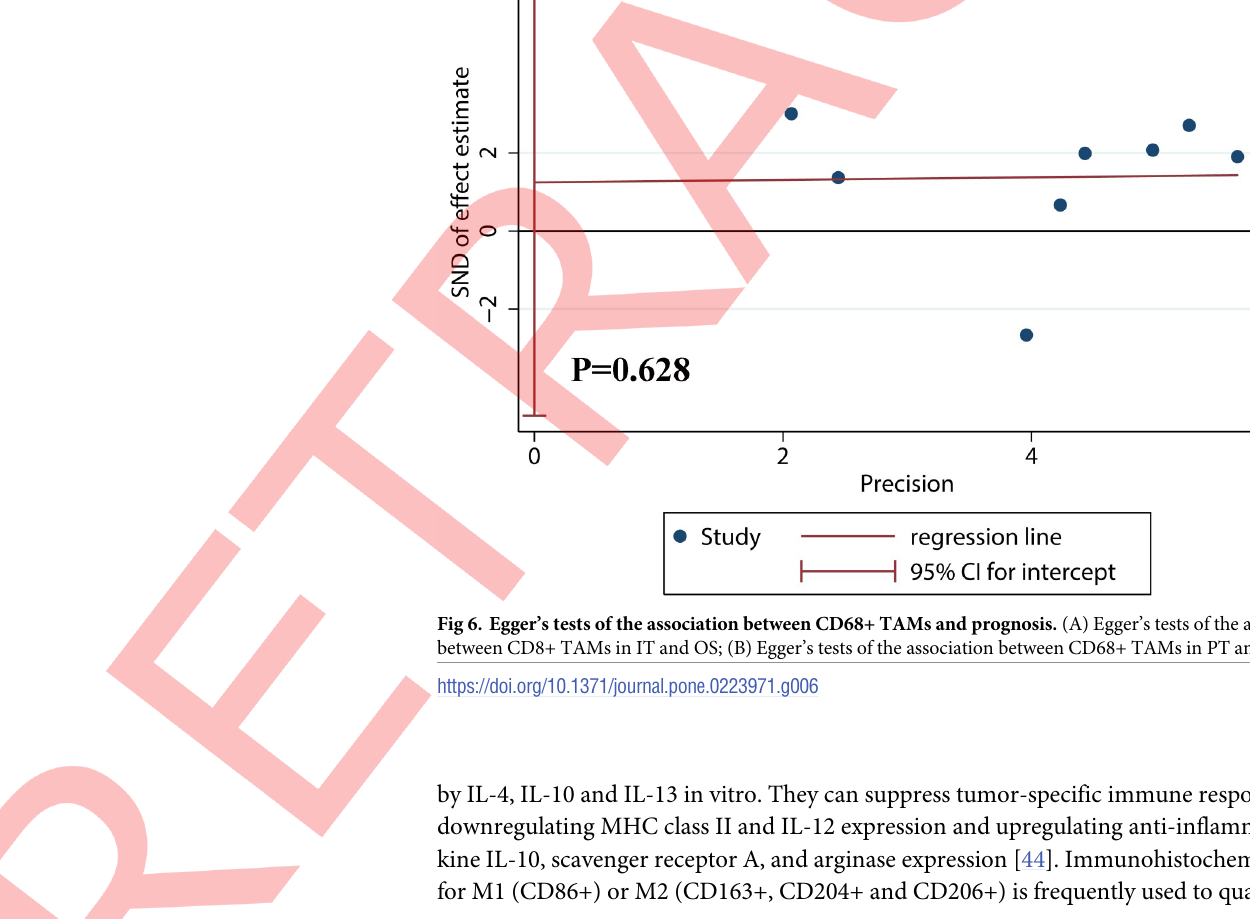
downregulating MHC class II and IL-12 expression and upregulating anti-inflammatory cyto- kine IL-10, scavenger receptor A, and arginase expression [44]. Immunohistochemical staining for M1 (CD86+) or M2 (CD163+, CD204+ and CD206+) is frequently used to quantify and